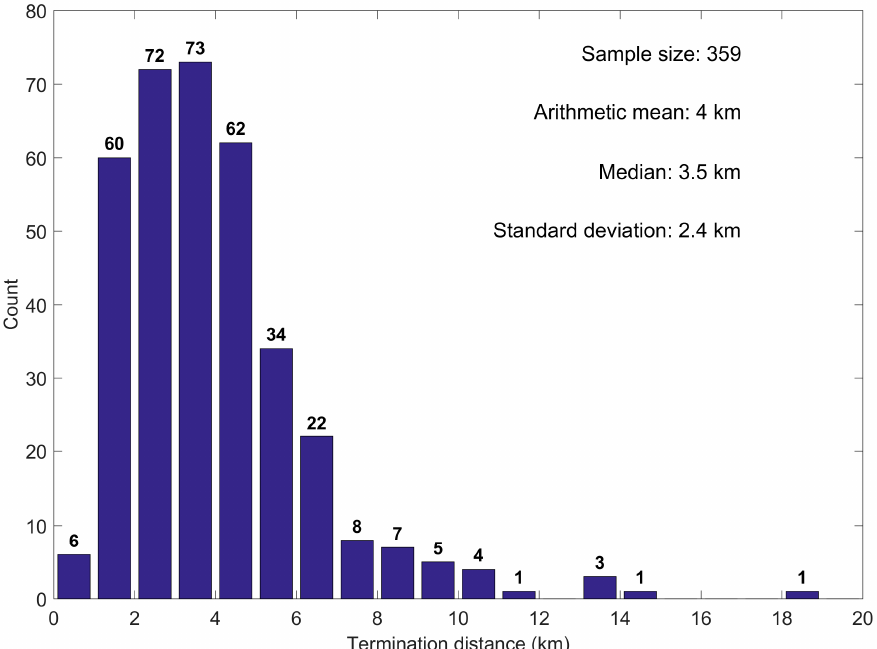
Figure 4. Histogram of the distance between any two terminations in each multiple-termination CG lightning flash.